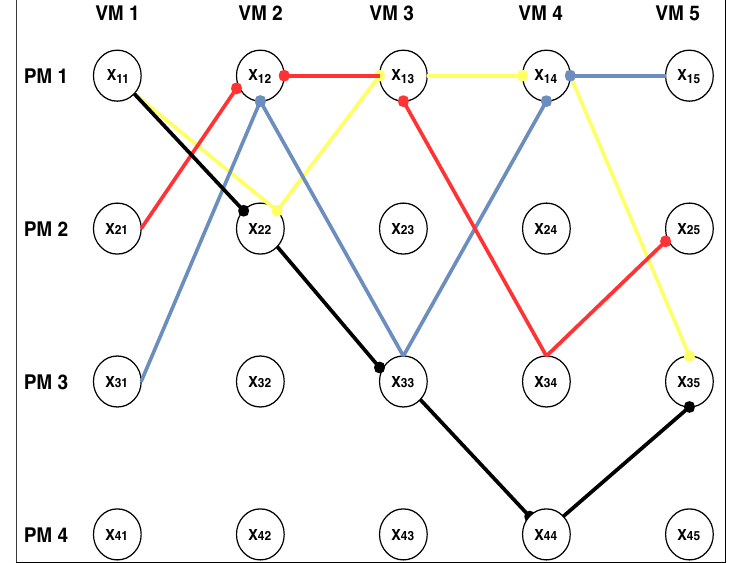
Figure 1. Example of feasible